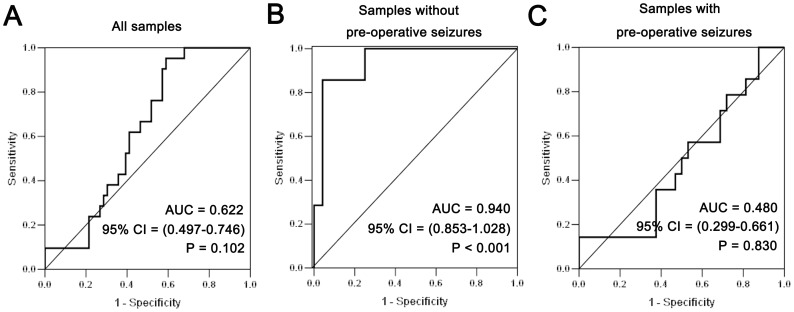
Association of miR-196b expression by qPCR with post-operative seizure control in patients without pre-operative seizures.(A) The predictive power of miR-196b expression in all patients. (B) The predictive power of miR-196b expression in all patients without pre-operative seizures. (C) The predictive power of miR-196b expression in all patients with pre-operative seizures.